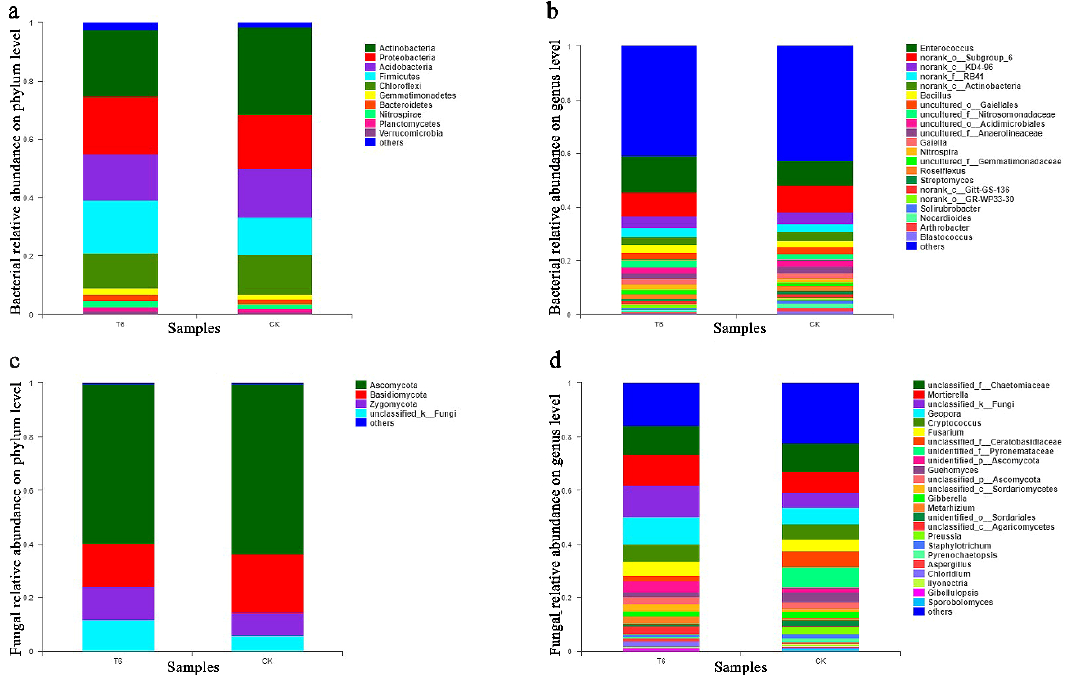
Figure 3. Structures of communities of bacteria and fungi in study groups ( a ) Phylum level bacterial relative abundance ( b ) Genus level bacterial relative abundance ( c ) Phylum level fungal relative abundance ( d ) Genus level fungal relative abundance. Stacked bar graphs illustrating major genera relative abundances. The T6-1 group consisted of poplar trees, which were exposed to bacterial zymotic fluid with T6-1. The CK group consisted of poplar trees, which were exposed to an equivalent volume of sterile zymotic fluid. We analyzed three replicates for every treatment. The non-metric multidimensional scaling (NMDS) plot on OTU level could be found in Supplementary Figure